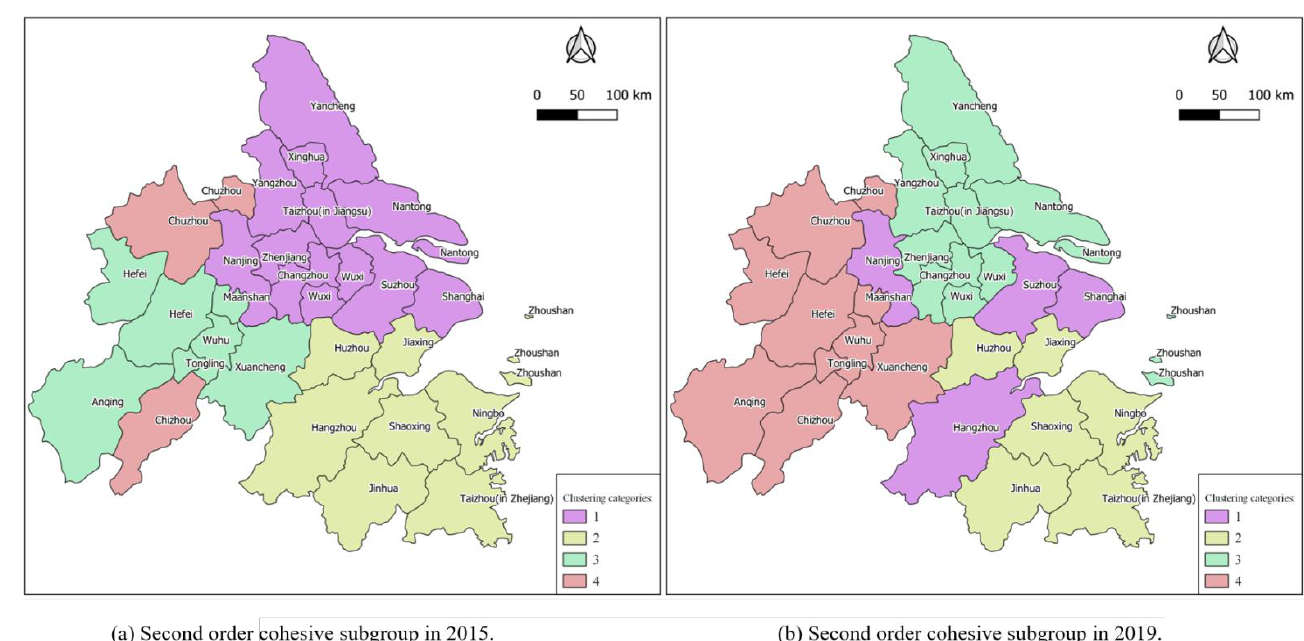
Figure 10. Second order cohesive subgroup: (a) 2015; (b) 2019.